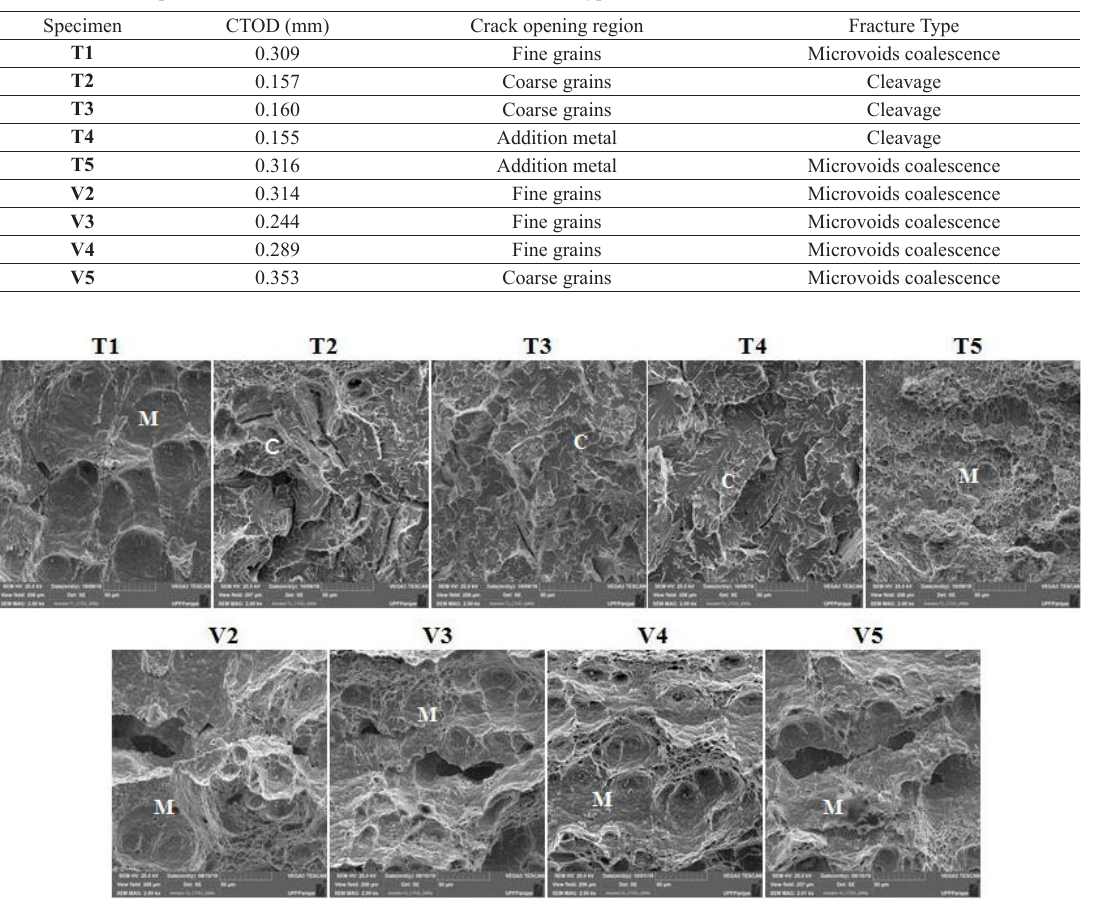
Figure 9. Fracture types found in the fractographic analysis for specimens relieved by heat treatment (T) and vibration (V), where M (Microvoids) and C (Cleavage).